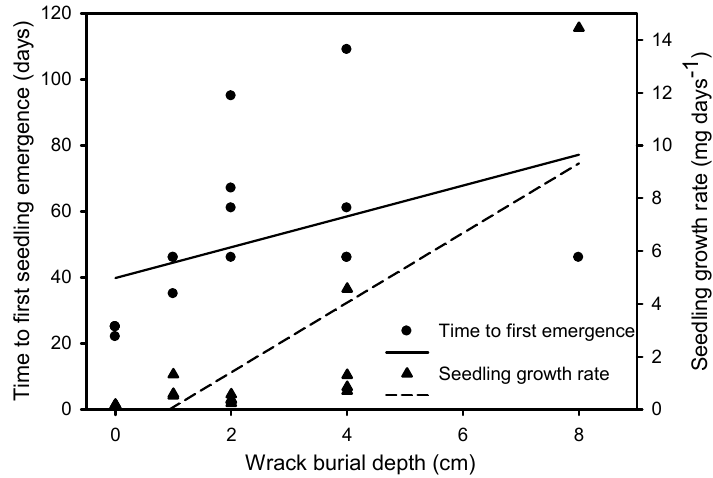
Figure 4. Relationships between the time to first seedling emergence ( ∂ ) and seedling growth rate ( ▲ ) of Iris pseudacorus with wrack burial depth. Regression equations: Time to first seedling emergence, y = 39.851 + 4.668x, R 2 = 0.170, p = 0.004, and n = 16; Seedling growth rate, y = 1.227 + 1.318x, R 2 = 0.638, p < 0.0001, and n = 16.